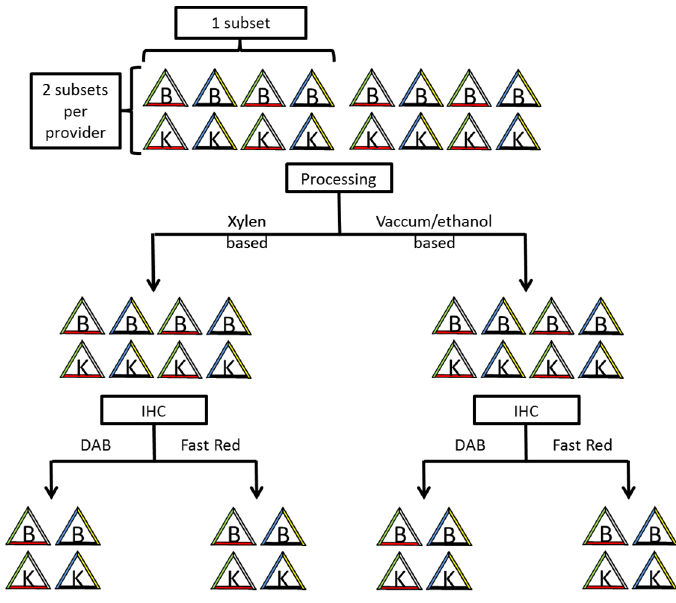
Figure 3. Suggested workflow for evaluation of TMD colour fastness. Two subsets of triangular-shaped tissues marked with a different colour on each side. Two different processing (Xylen and Vaccum/ethanol based) and IHCs with two different chromogens (DAB and Fast Red) per provider.